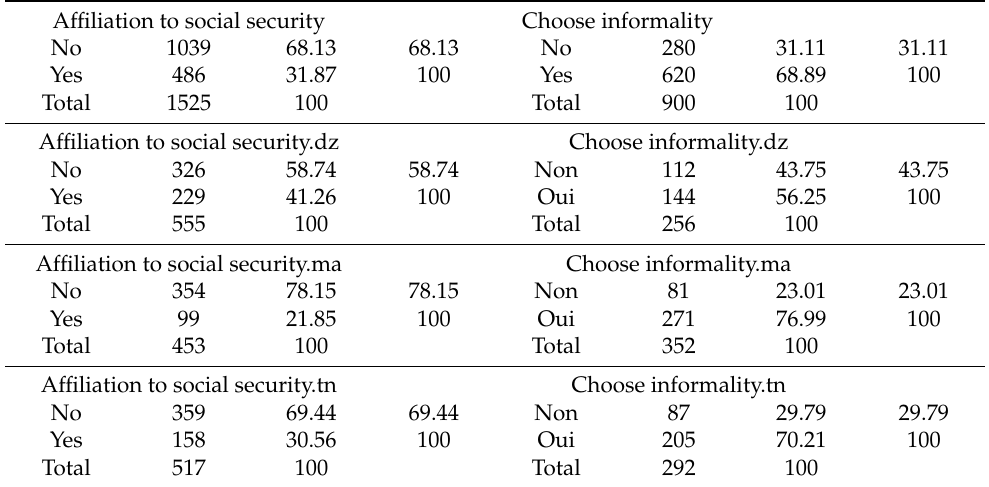
Table A1. Affiliation to social security and the reasons for not being insured. Source: Sahwa dataset.